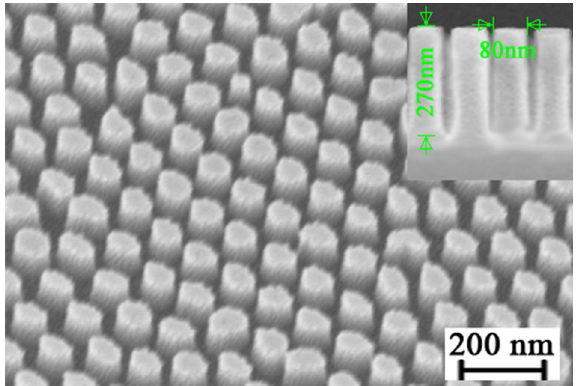
Figure 5. SEM images of the 20 nm Au-coated polymeric nanowire substrate for SERS measurement, and the inset shows cross-sectional view of the nanowires.